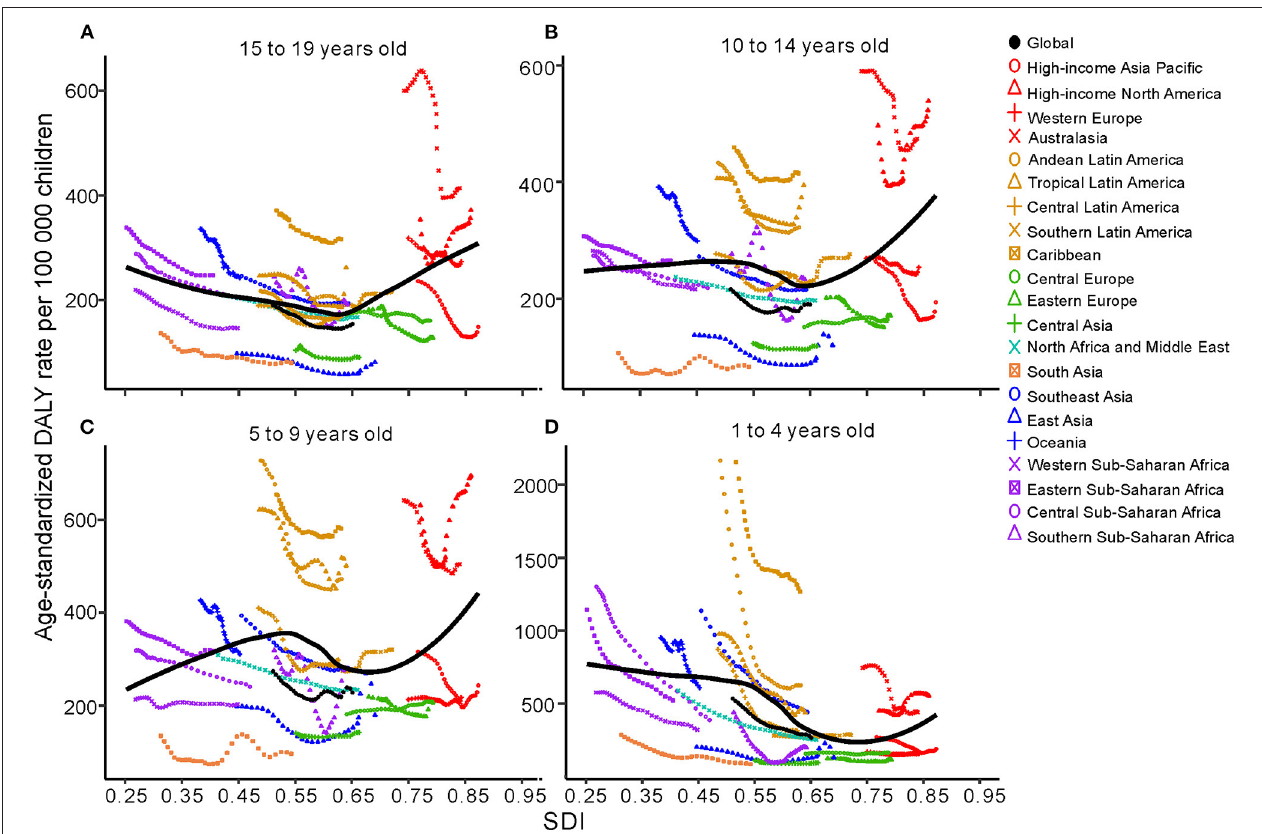
FIGURE 4 | Age-standardized DALYs due to childhood asthma by 21 GBD regions and different age groups, 1990–2019; the black line represents expected values by SDI. (A) Change trends of age-standardized DALYs for regions by SDI in 15 to 19 years olds. (B) Change trends of age-standardized DALYs for regions by SDI in 10 to 14 years olds. (C) Change trends of age-standardized DALYs for regions by SDI in 5 to 9 year olds. (D) Change trends of age-standardized DALYs for regions by SDI in 1 to 4 year olds. DALYs, disability adjusted life years; SDI, sociodemographic index.